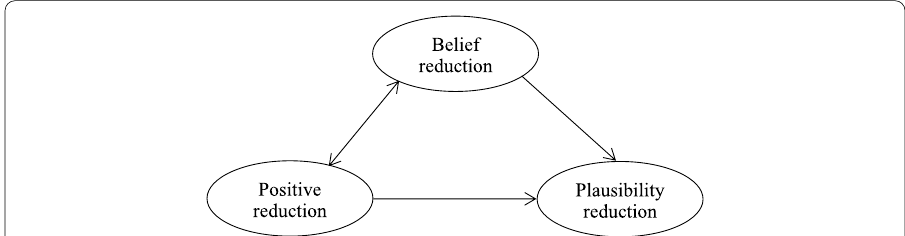
Fig. 2 The consistency of several reductions in the same levels of